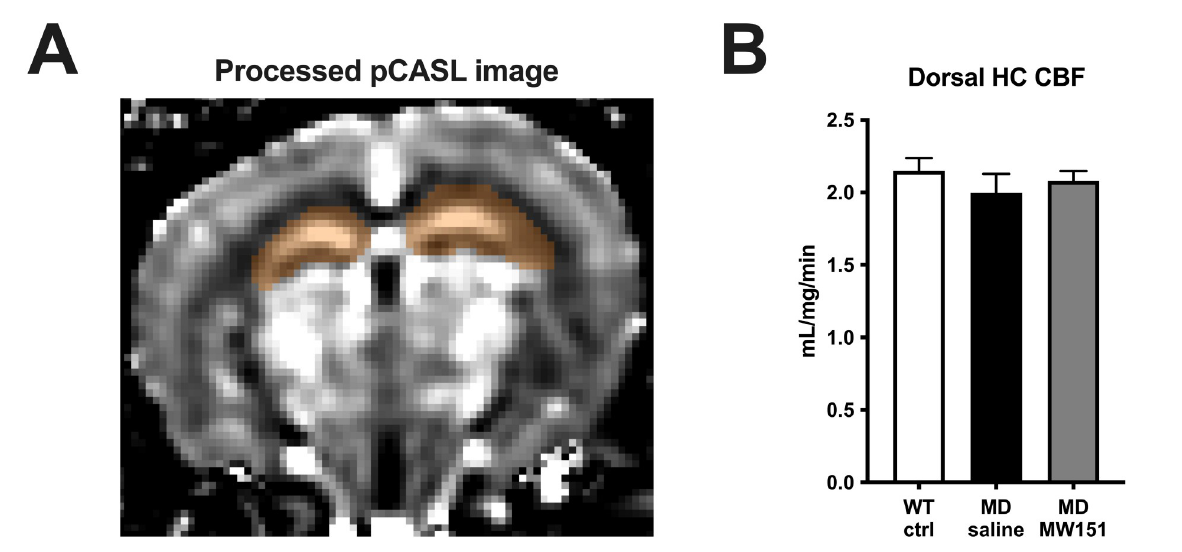
Fig 3. Hippocampal blood flow is unimpaired in MD mice after HHcy recovery and unaltered by treatment with MW151. ( A ) Perfusion- weighted pCASL image is shown, with the bilateral dorsal hippocampal region of interest colored in brown. ( B ) Quantification of group averages showed no difference between any of the groups by one-way ANOVA ( F (2, 27) = 0.602, p = 0.555).